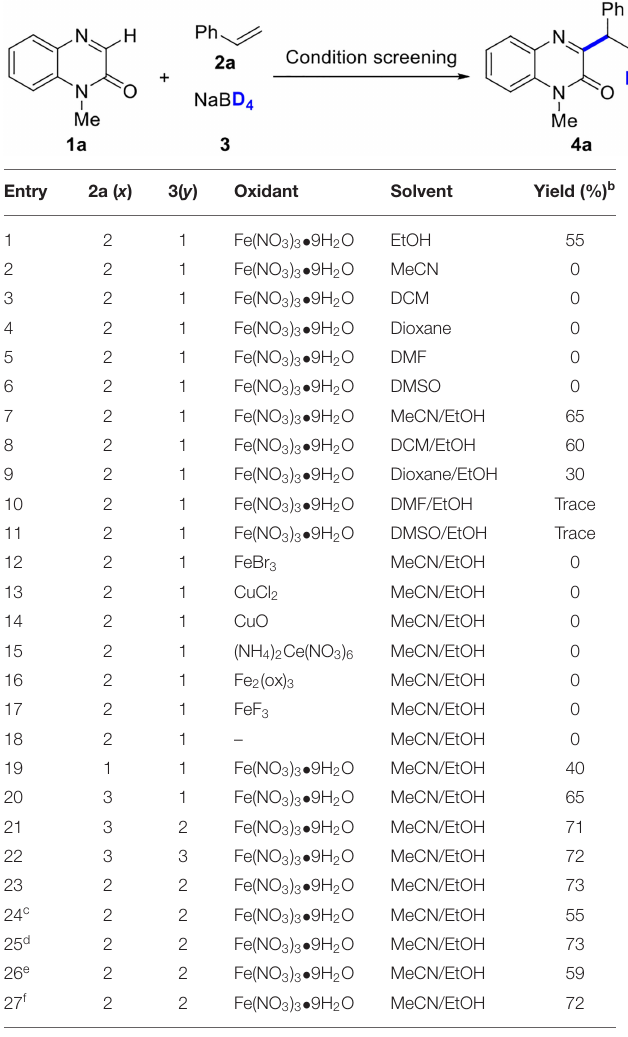
TABLE 1 | Optimization of reaction conditions a